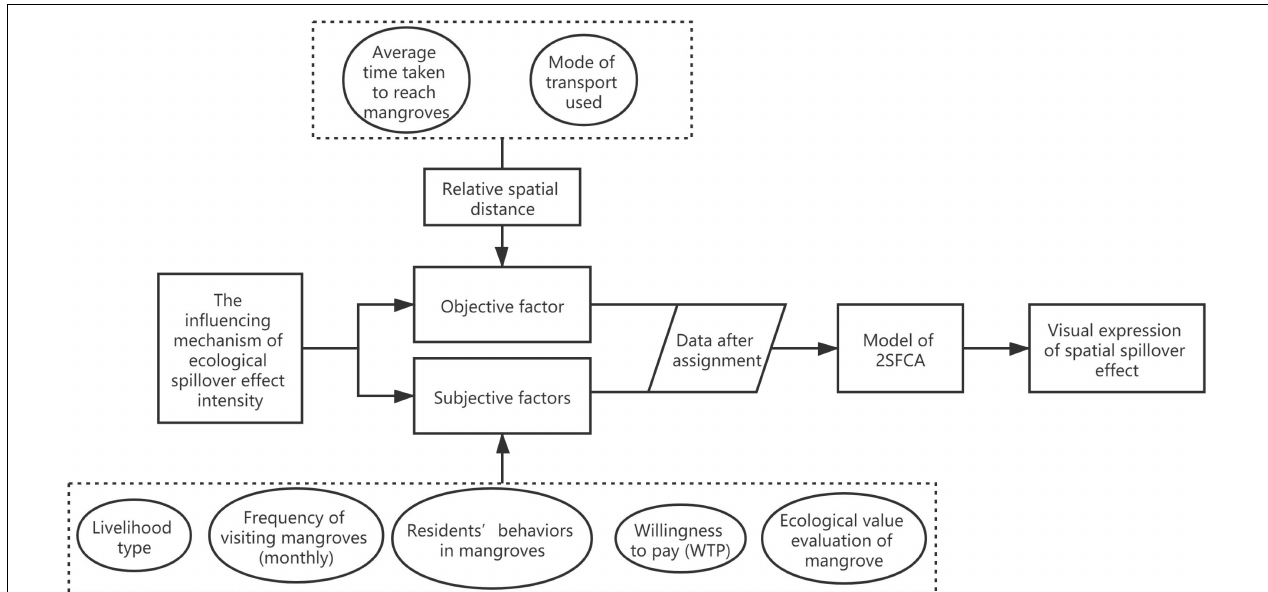
FIGURE 1 | The research